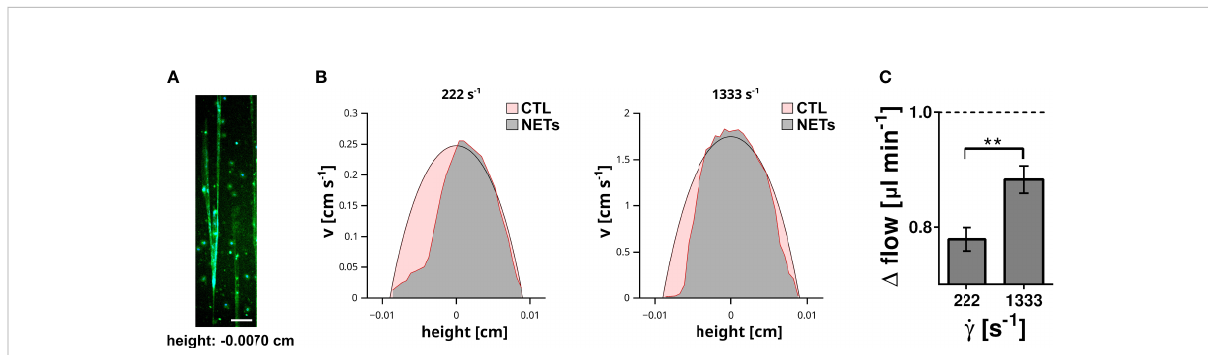
FIGURE 4 Impact of surface immobilized NETs on fl uid fl ow. (A) NETs immobilized at the bottom (height = -0.007 cm) of the fl ow channel. DNA was stained with DAPI (blue) and EvaGreen (green). Scale bar = 100 µm. (B) The velocity (v) of microparticles within the fl ow channel was measured by microparticle velocimetry. Flow velocity pro fi le recorded at a shear rate of 222 s -1 and 1333 s -1 are shown. The pro fi le measured in control channels (red area) were superimposed with the pro fi le measured in NET containing channels (grey area). (C) Impact of the shear rate ( ̇ g ) on the total fl uid fl ow. Shown is the change of the total fl ow in comparison to the corresponding fl ow within the control channels. The fl ow in the control channel is indicated by the dashed line. **p< 0.01, Fisher z